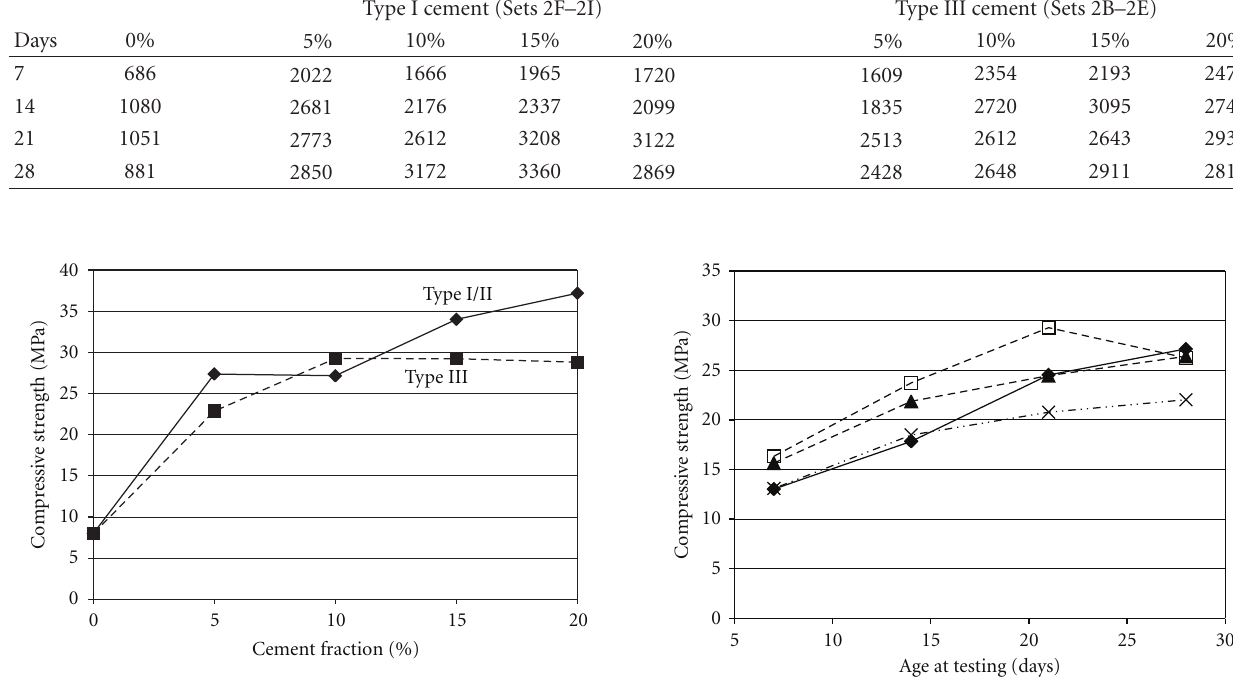
Figure 5: Comparison of compressive strength at 28 days for mixtures with type I/II and type III cement.